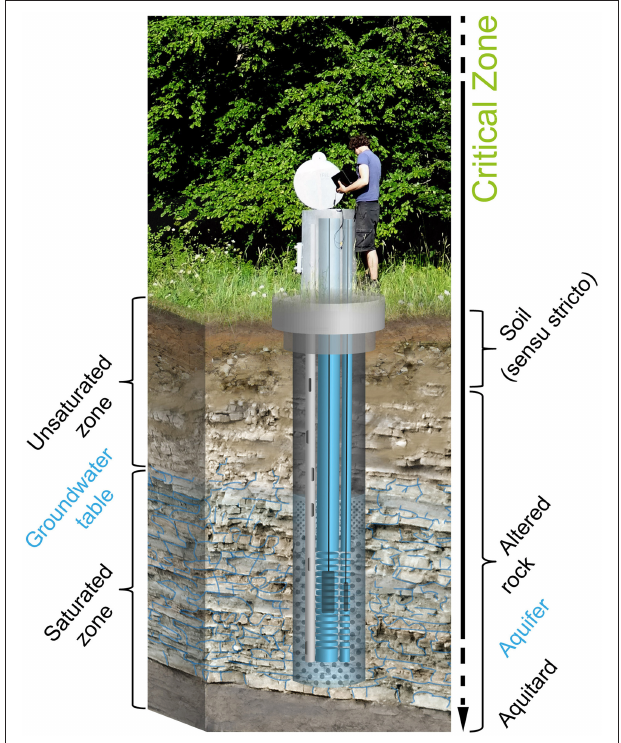
FIGURE 1 | Schematic identifying the near surface compartments of the Earth’s Critical Zone (CZ). Also illustrated is our multi-tube well